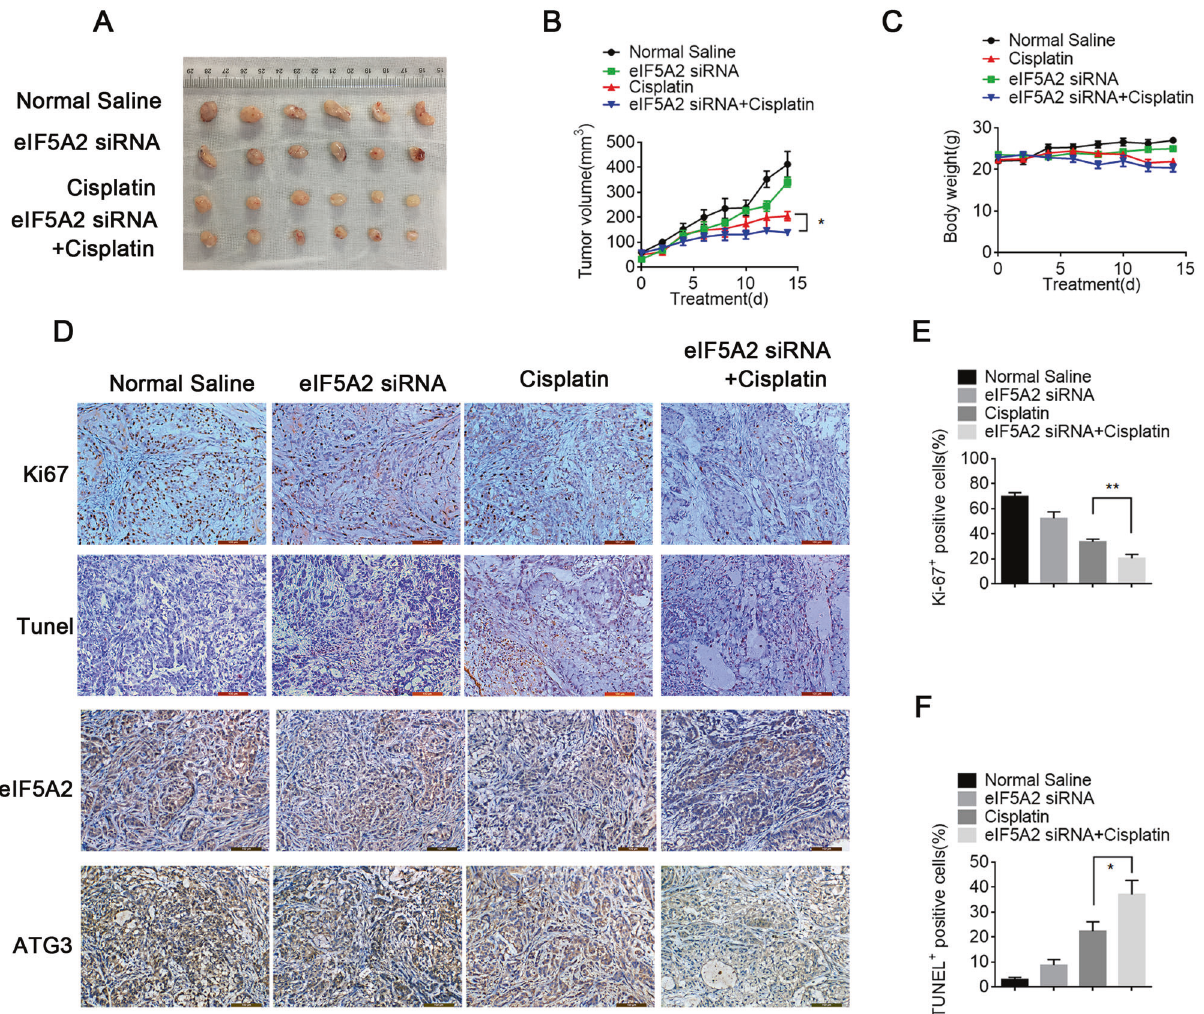
Fig. 6 Targeted silencing of eIF5A2 increases cisplatin sensitivity in vivo. A The stripped NSCLC tissues were arranged as shown. B Tumor volume curve showing that the nude mice silenced for eIF5A2 and treated with cisplatin had the smallest tumor volume, which was statistically signi fi cant. C There was no statistical difference in the body weight of nude mice among the groups. D – F According to the results of IHC ( D ), the nude mice silenced for eIF5A2 and treated with cisplatin had the lowest expression of Ki67 ( E ) and the highest level of TUNEL staining ( F ). * P < 0.05, ** P < (Fig. 6F), indicating that the combined treatment effectively reversed hypoxia-induced autophagy and inhibited NSCLC devel- opment (Fig. 6D, F and Fig. S2).